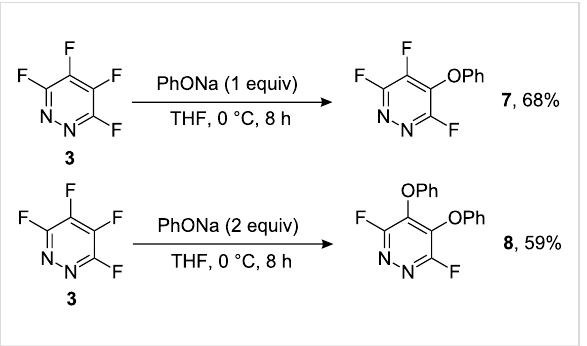
Scheme 3: Reactions of tetrafluoropyridazine 3 with sodium phen-